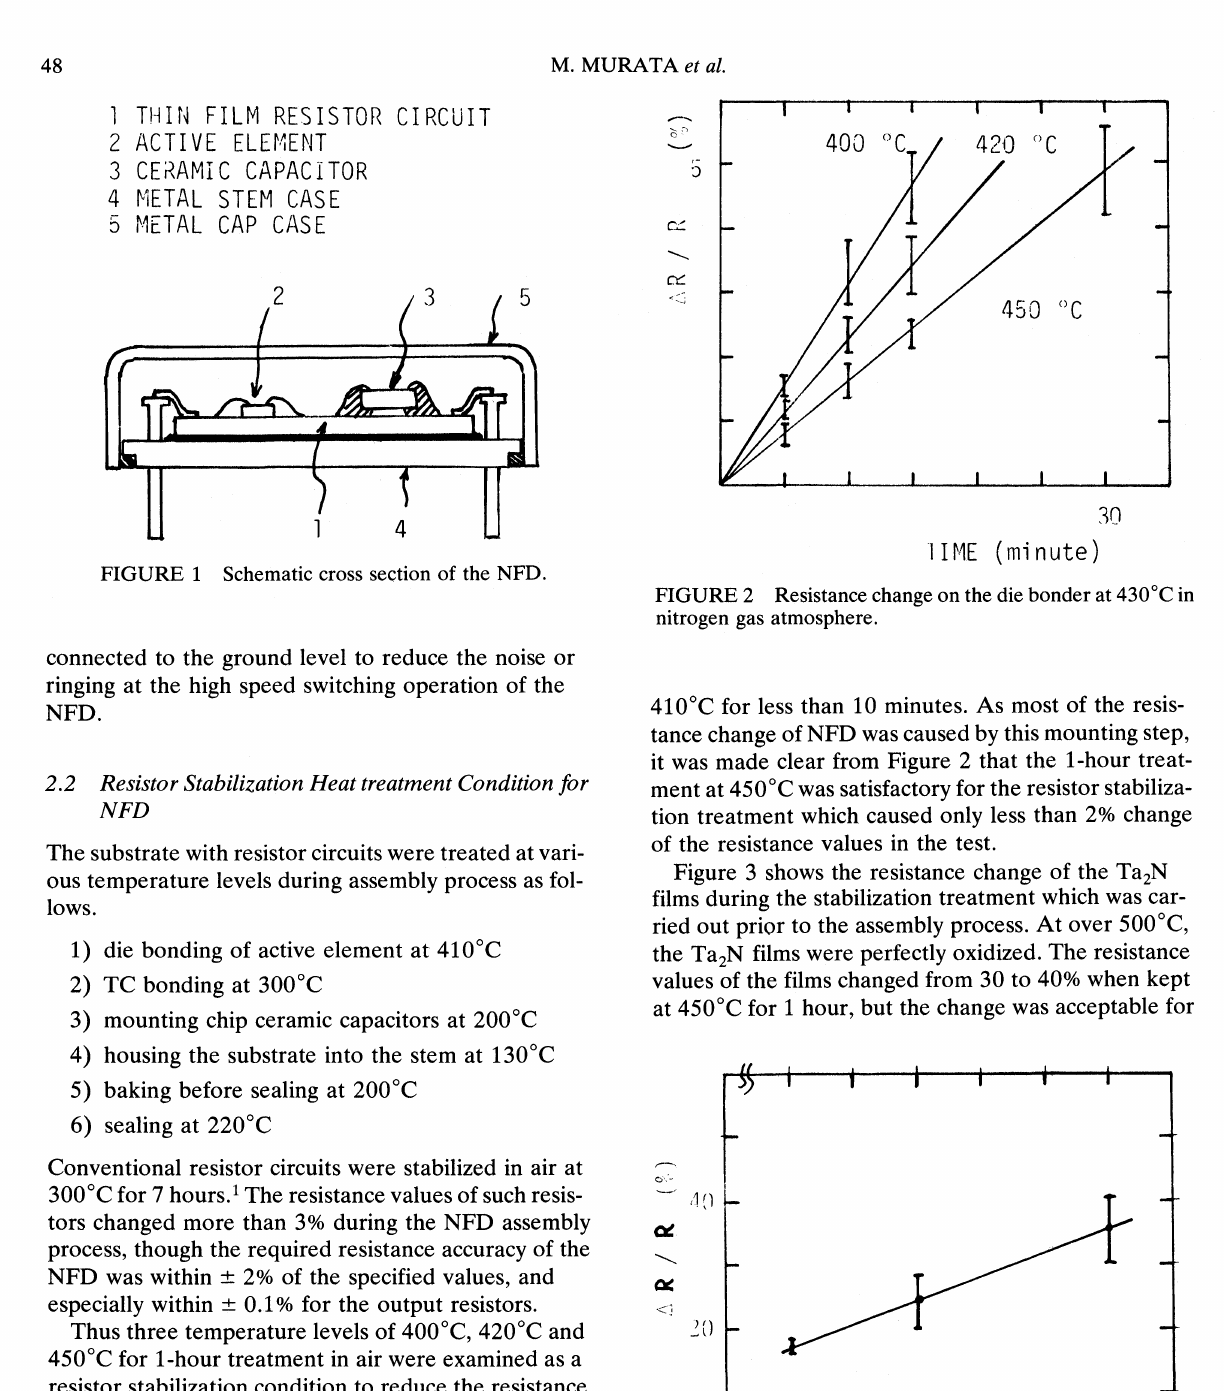
FIGURE 3 Resistance change at heat treatment for